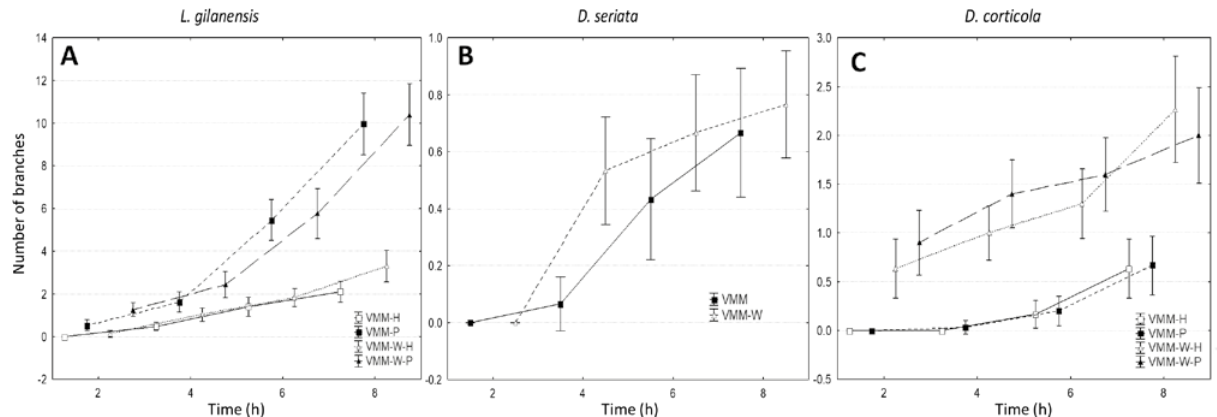
Figure 5. Mean numbers of hyphal branches produced by pigmented (P) or hyaline (H) pycnidiospores of Lasiodiplodia gilaniensis (A), Dip- lodia seriata (B), or D. corticola (C), in the absence (VMM) or presence of grapevine wood (VMM-W) in the growth medium. The presence of grapevine wood affected the branching of D. corticola